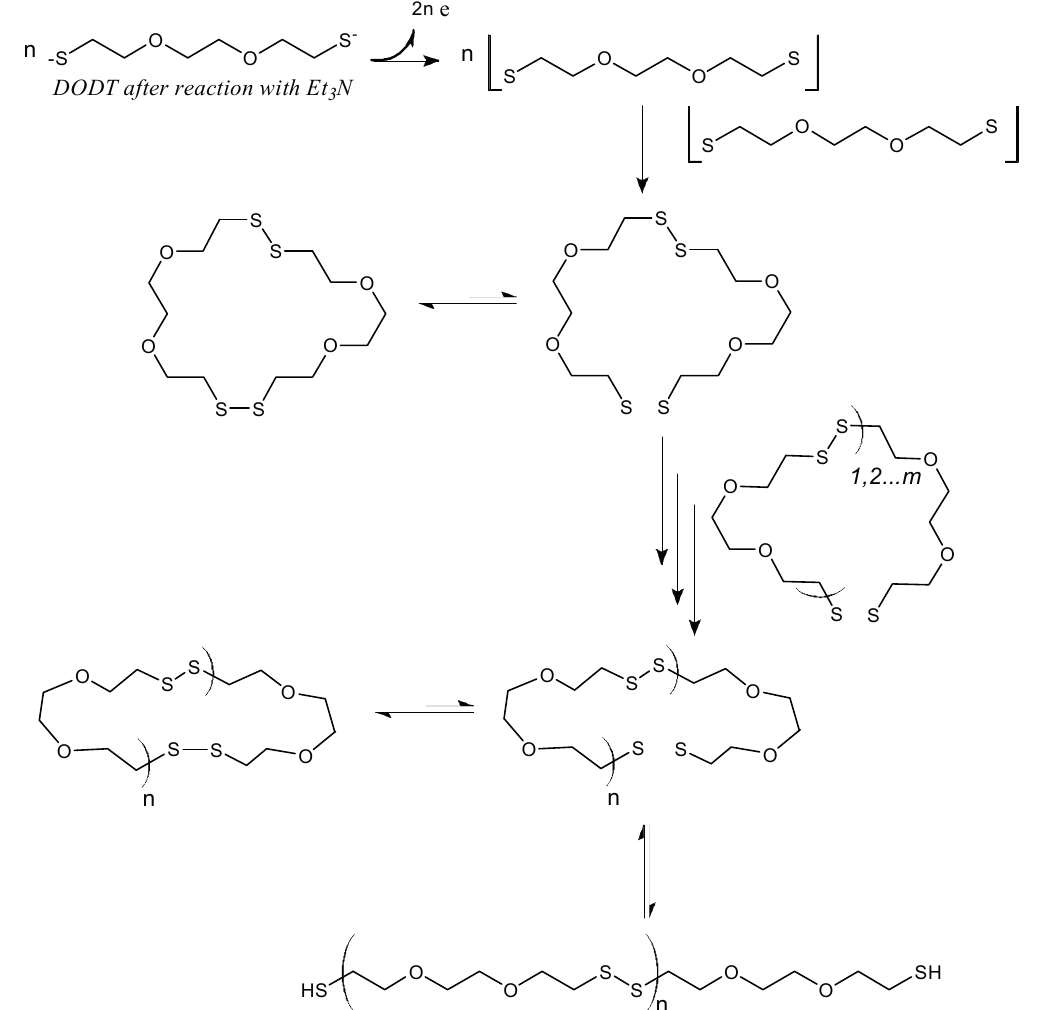
Scheme 2. Proposed mechanism of Radical Ring-opening Redox Polymerization, R3P . (Reprinted with permission from [4]. Copyright 2012 American Chemical